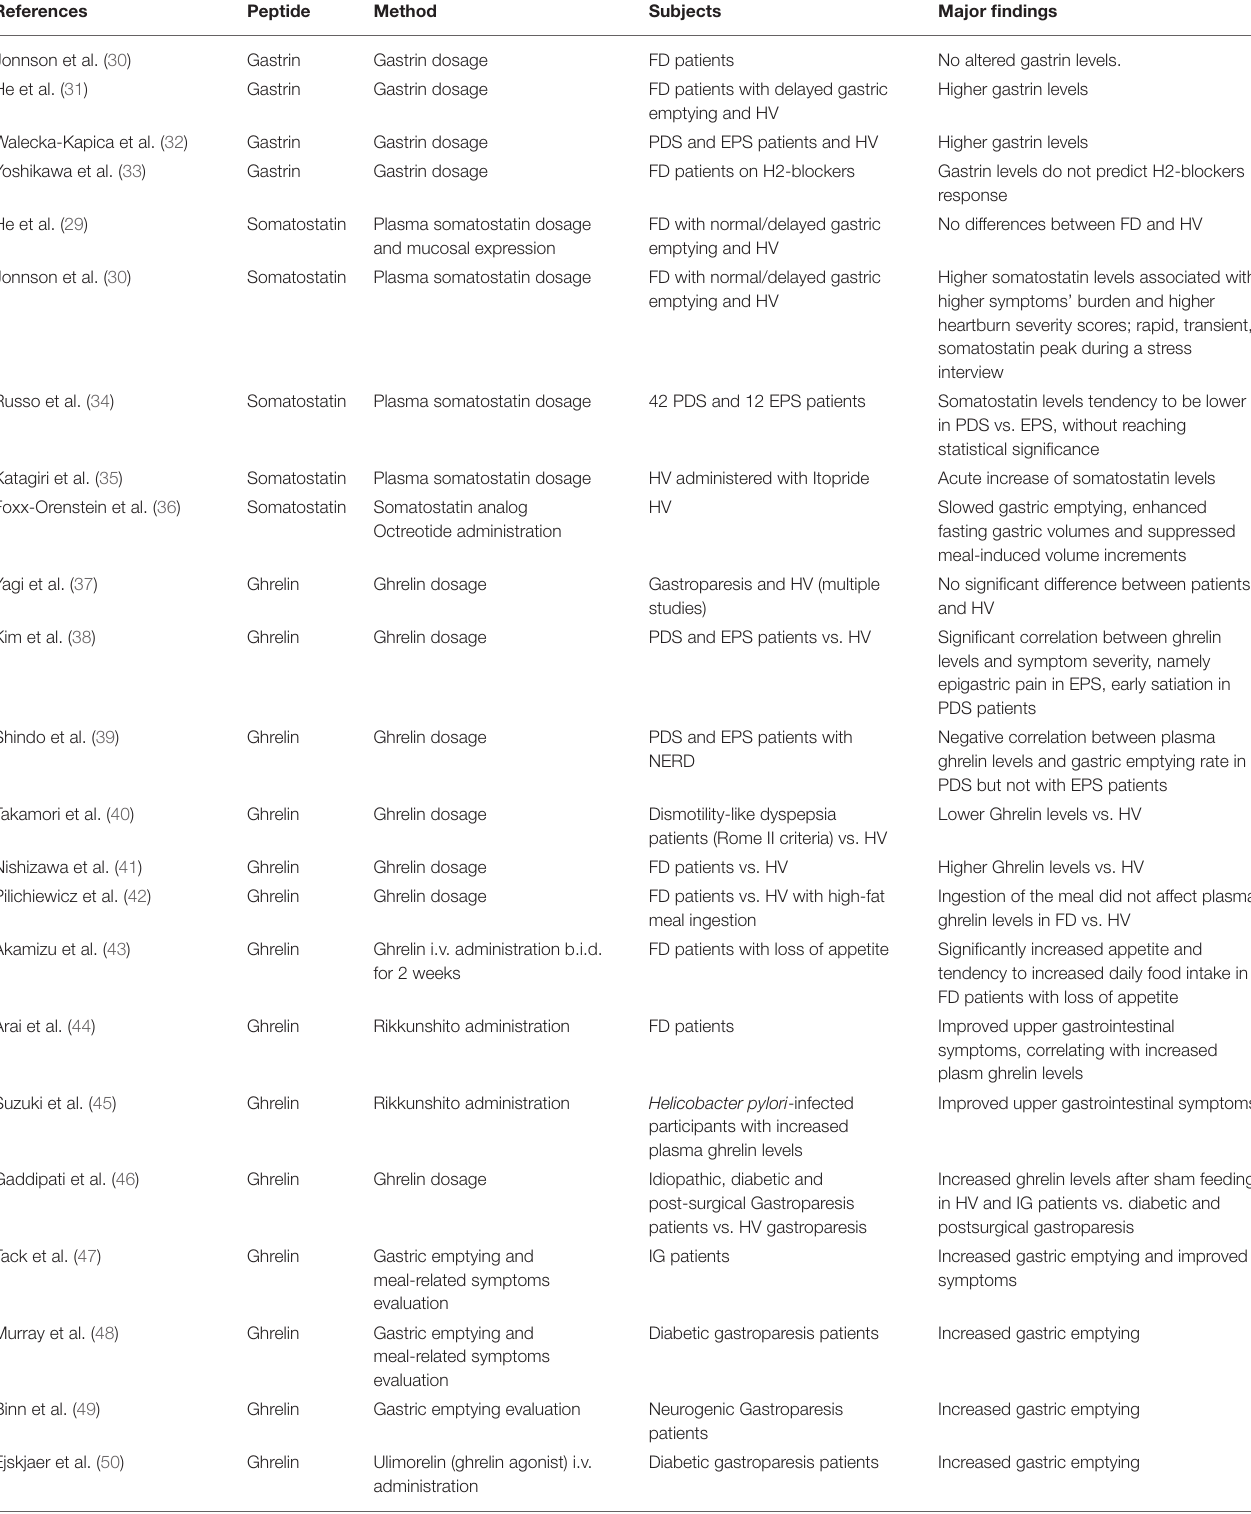
TABLE 1 | Summary findings on the link between gut peptides, functional dyspepsia, and